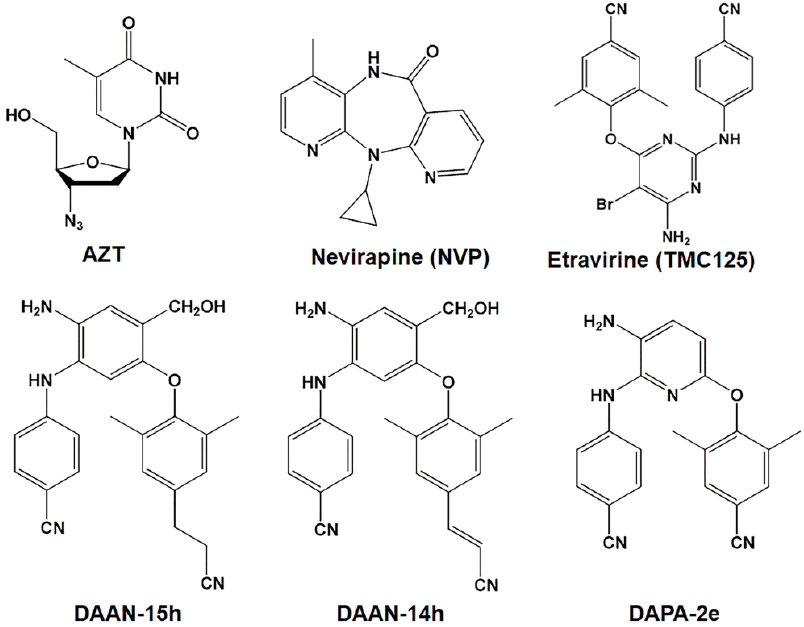
Figure 1. Chemical Structure of the nucleoside reverse transcriptase inhibitor (NRTI) azidothymidine (AZT) and five non-nucleoside reverse transcriptase inhibitors (NNRTIs), including Nevirapine (NVP), Etravirine (TMC125), diarylanilines (DAANs)-15 h, DAAN-14 h, and diarylpyridines (DAPA)-2e.